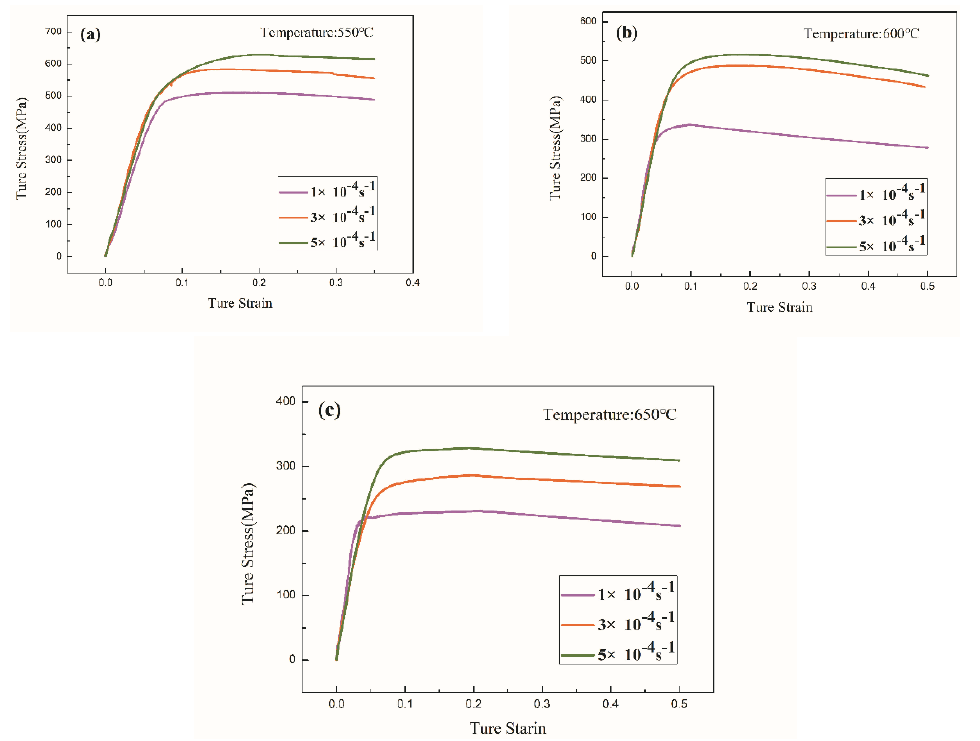
Figure 10. True stress-strain curves of TiH 2 -7Al-0.2B at different temperatures and compressive rates.